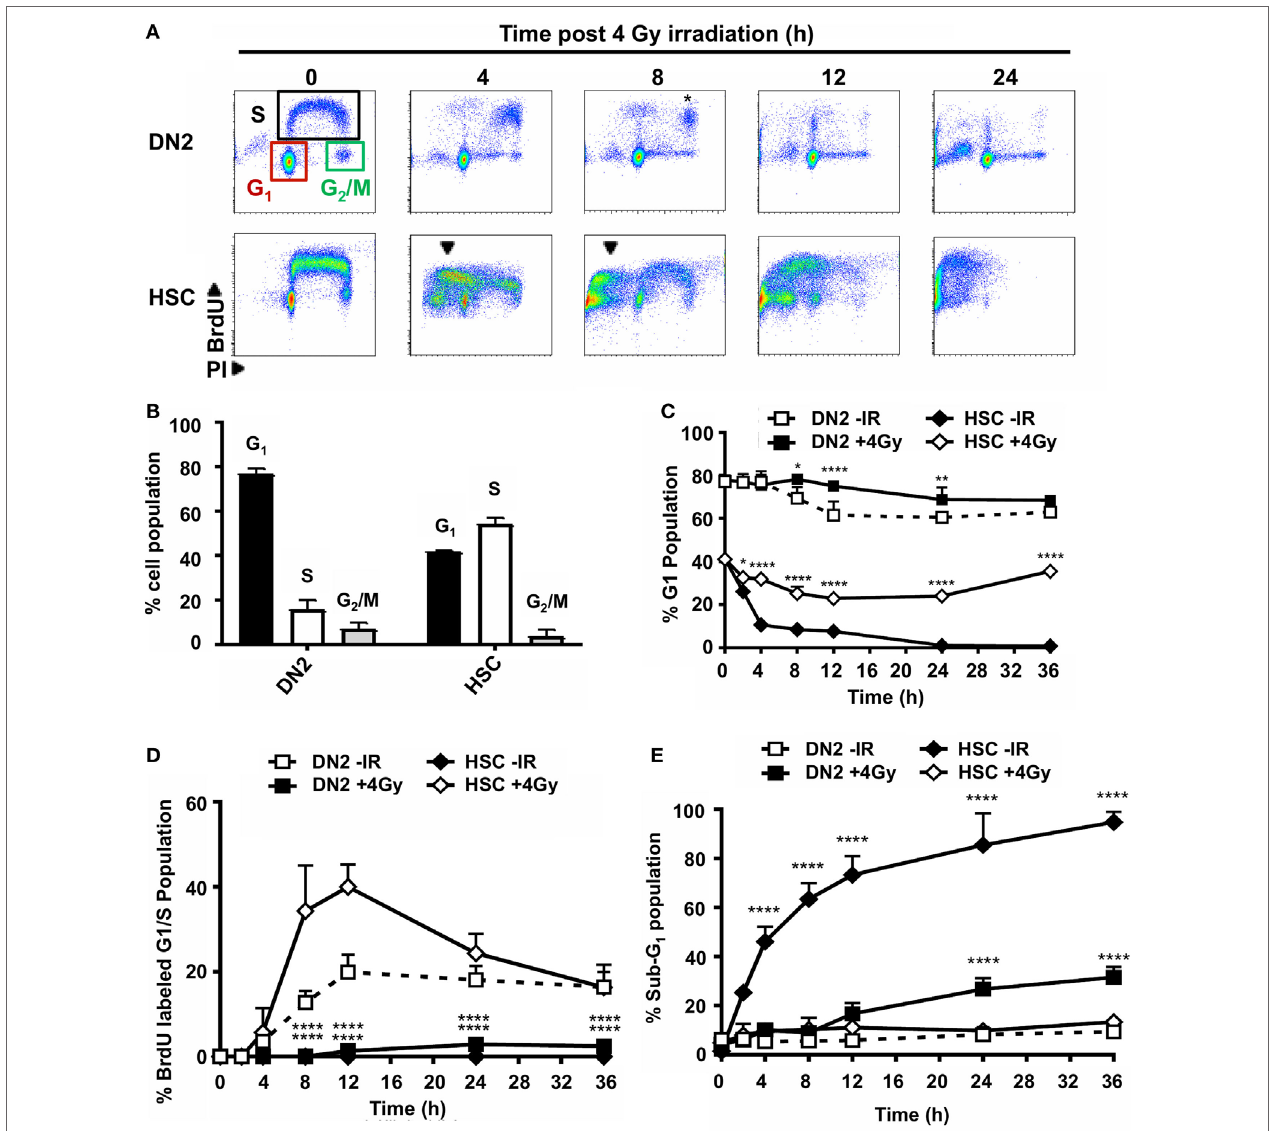
FigUre 2 | Double-negative (DN)2 thymocytes activate DNA damage checkpoints. (a) Representative cytograms of DN2 and NH-hematopoietic stem cells (HSCs) at 0–24 h post 4 Gy irradiated and stained for bromo-deoxyuridine (BrdU) incorporation and DNA content using propidium iodide (PI). Colored boxes are used to indicate G 1 , S, and G 2 /M phase cells under control conditions; black arrowheads indicate sub-G 1 cells and * indicates cohort of BrdU-labeled DN2 cells accumulated in late S/G 2 . (B) Quantification of the percentage DN2 and NH-HSCs in each phase of the cell cycle under normal conditions. (c) Quantification of the percentage G 1 DN2 cells and NH-HSCs at 0–36 h post-irradiation or under normal conditions. (D) Quantification of the percentage BrdU-labeled G 1 /early S phase DN2 cells and NH-HSCs at 0–36 h post-irradiation or under normal conditions. (e) Quantification of the percentage sub-G 1 DN2 cells and NH-HSCs at 0–36 h post-irradiation or under normal conditions All cytograms and graphs are representative of three independent experiments. Error bars represent mean ± SD, n = 3, * p < 0.05, ** p < 0.01, **** p < 0.0001. Two-way ANOVA analysis with Tukey’s multiple comparisons test was performed on the following conditions (i) DN2-ionizing radiation (IR) versus DN2 + 4 Gy and (ii) HSC-IR versus HSC + 4